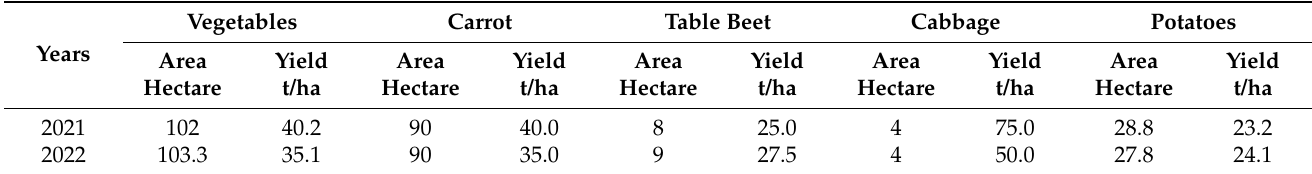
Table 1. Yield of vegetable crops on irrigated lands of Aksu district, Pavlodar region.